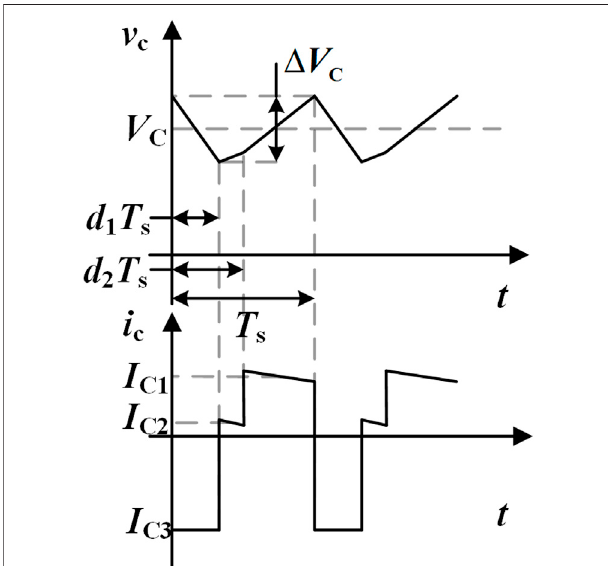
FIGURE 16 | Currents of the inductor and input capacitor in the TICC